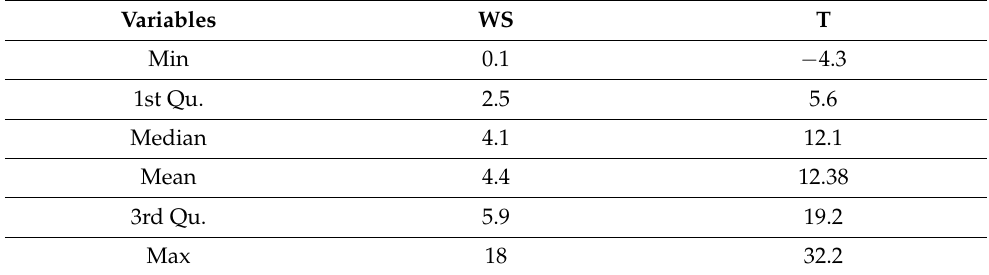
Table 1. Basic statistics for data (wind speed WS [ms − 1 ] and temperature T [ ◦ C]) were measured by hi-vol during the period of time from March to July 2021.